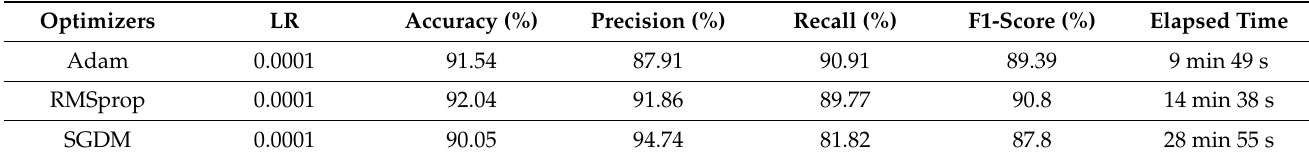
Table 7. Classification results of the proposed method using 5 s